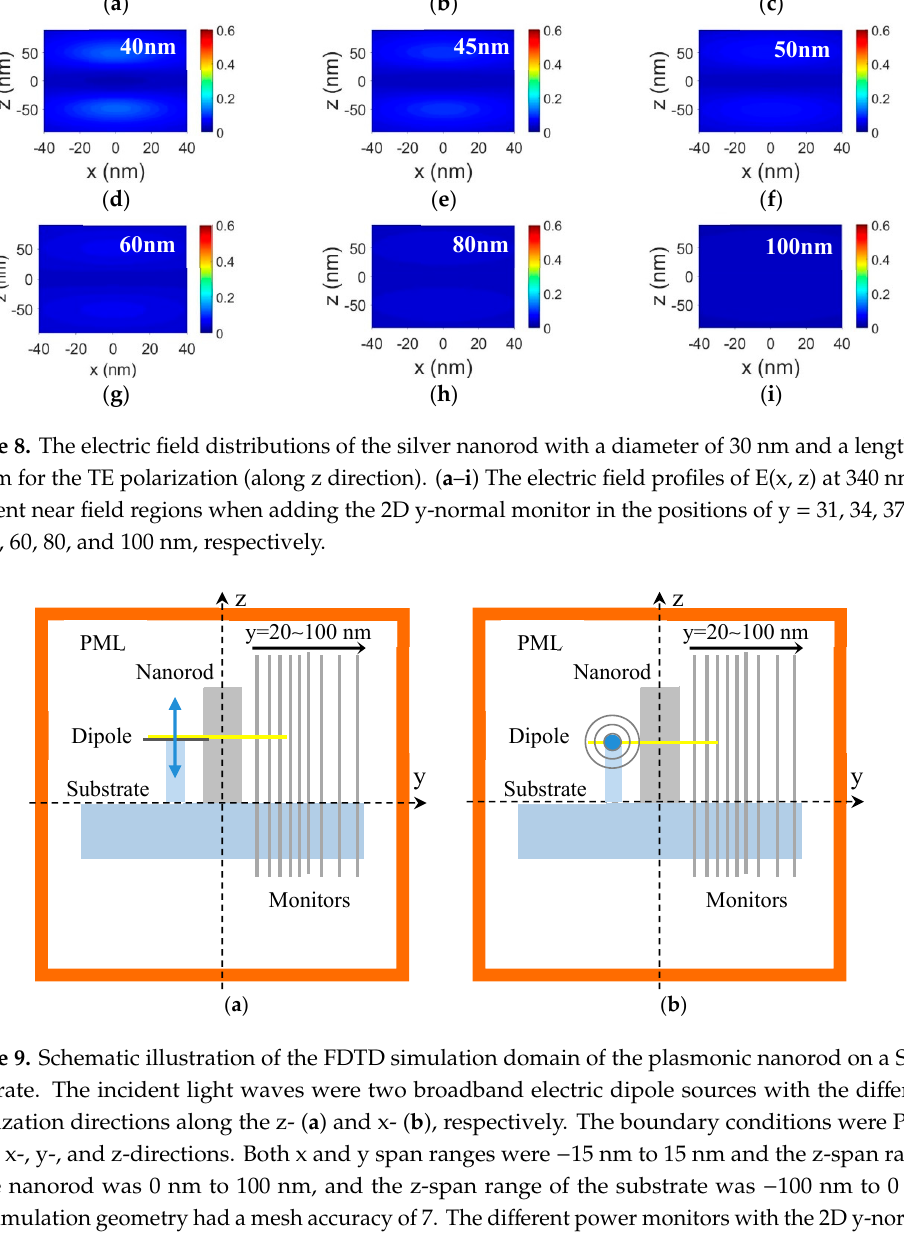
Figure 7. The electric field distributions of the single silver nanorod with a diameter of 30 nm and a length of 100 nm for the TM polarization of the incident light (along the x-direction). ( a – i ) The electric field profiles of E(x, z) at 340 nm in different near field regions when adding the 2D y-normal monitor in the positions of y = 31, 34, 37, 40, 45, 50, 60, 80, and 100 nm, respectively.